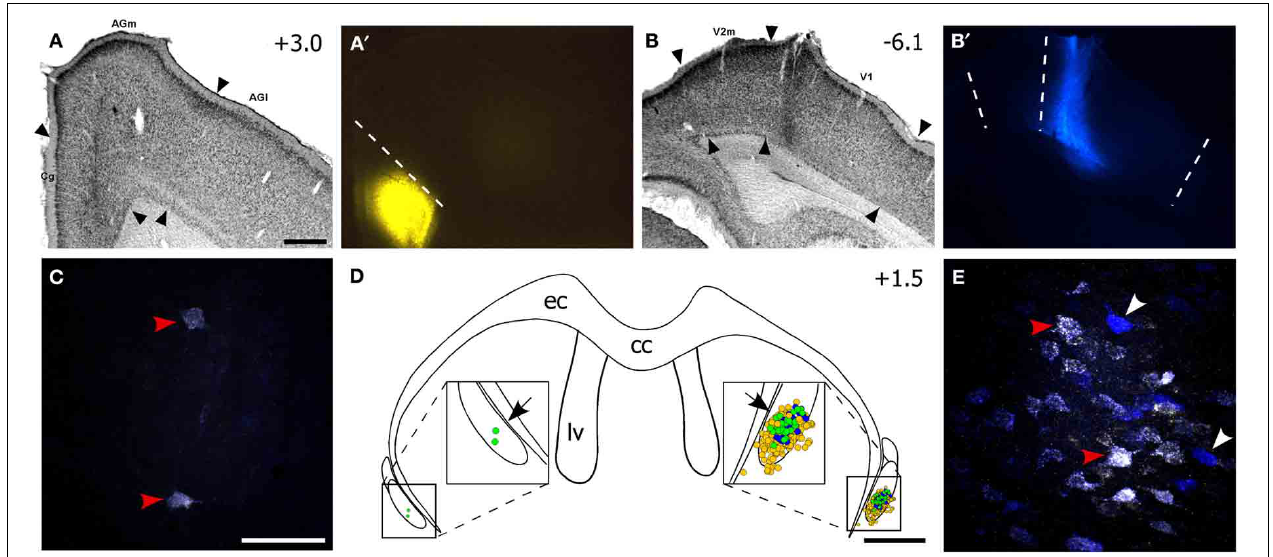
FIGURE 3 | The ventral claustrum projects to both FEF and V1. (A–B’) Fluorogold (FG) deposit in FEF and True Blue (TB) in V1 of the right hemisphere for the same case in Figure 2 . (C) Confocal image of two faintly double-labeled neurons in the left vCLA. (D) Reconstruction of labeled soma in the vCLA. Yellow and blue dots are FG- and TB-labeled soma, respectively,